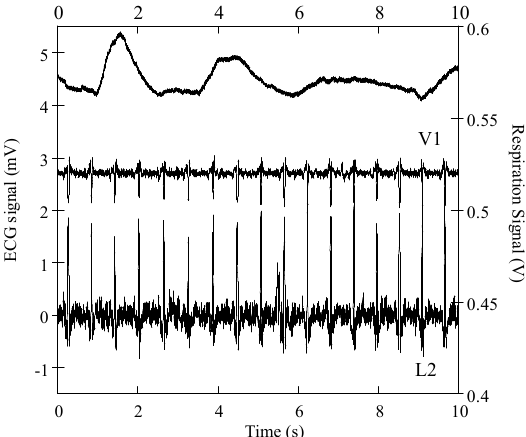
Sensors 2016 , 16 , 1573